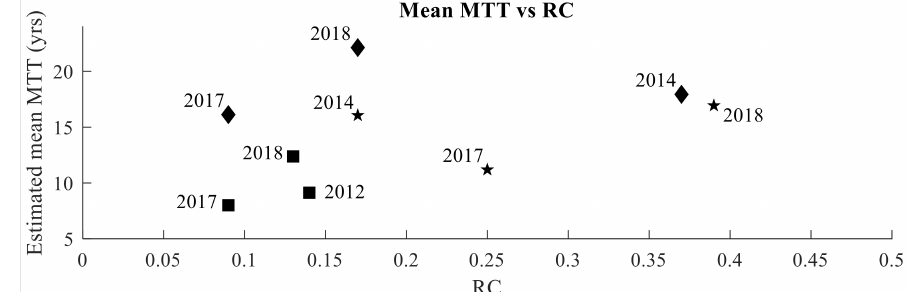
Figure 5. Baseflow Index (BFI) and Runoff Coefficient (RC) versus Mean MTT and TU. Mean MTT was calculated averaging the two samples of 2017 and 2018 as a baseflow annual MTT. For Q1, we took as pre-fire the 2012 samples; for Q2/Q3 the 2014 pre-fire samples were averaging as pre-fire